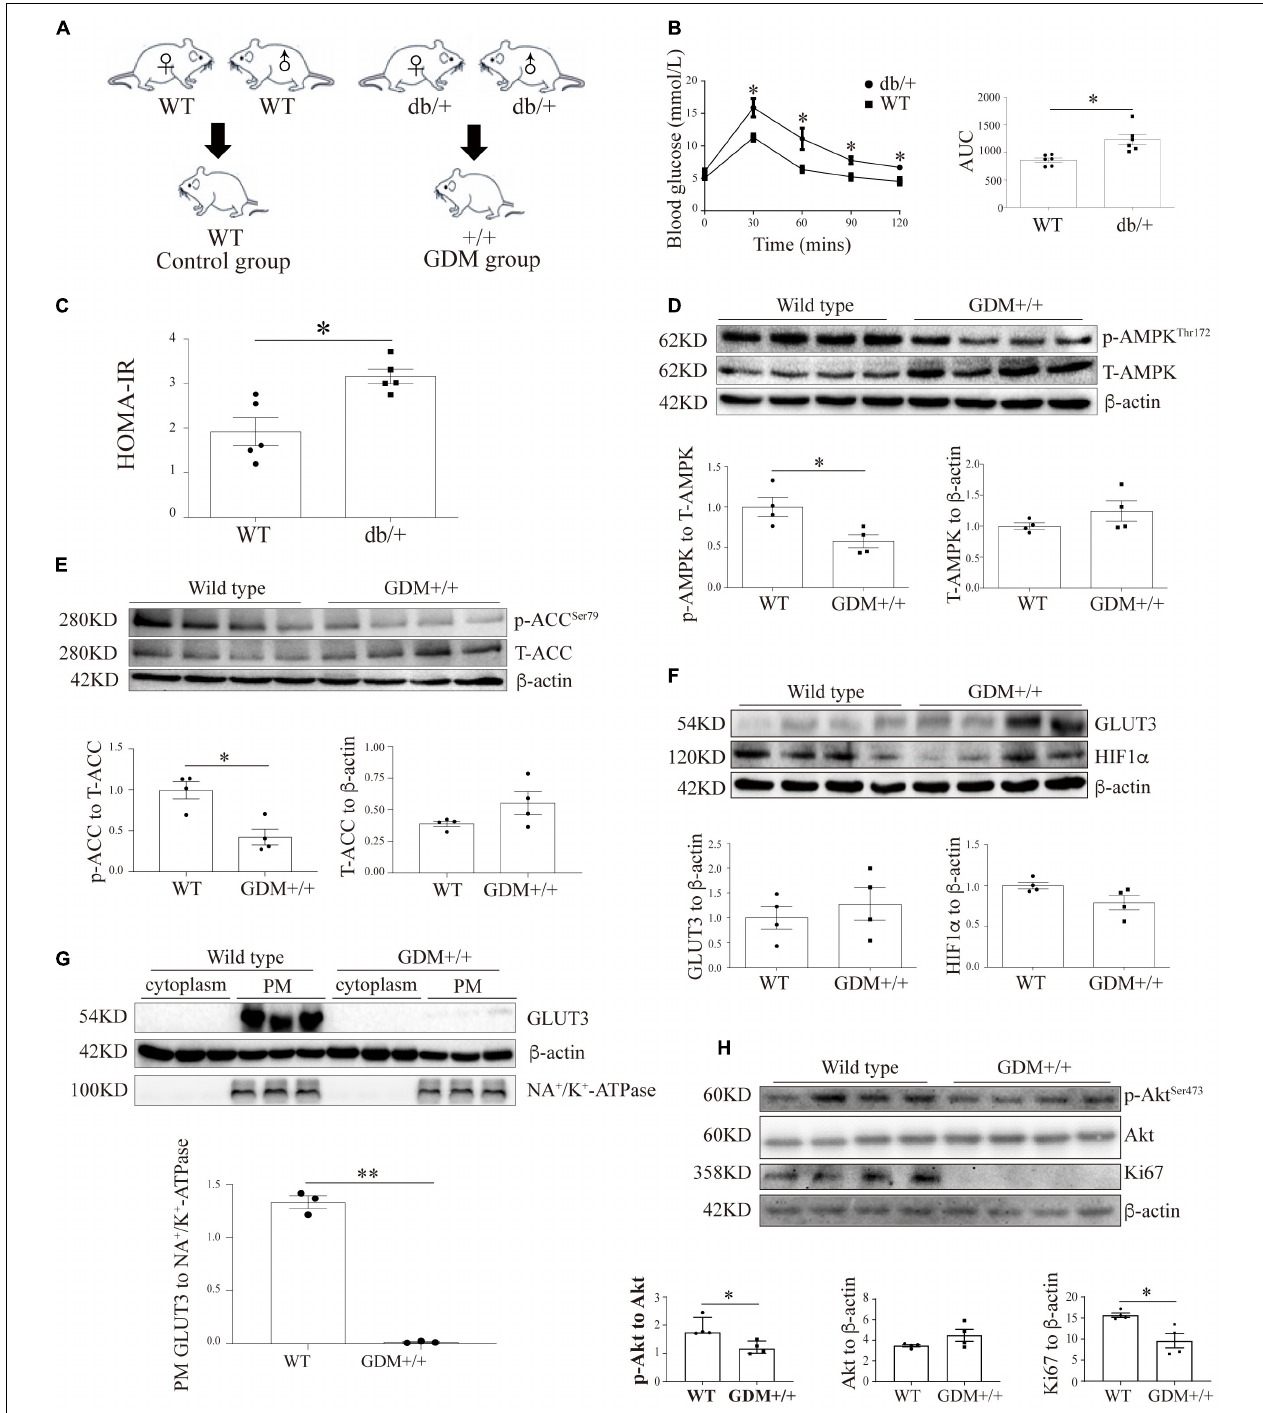
FIGURE 5 | The genetic GDM mouse model is associated with compromised AMPK signaling and altered GLUT3 membrane localization in placental tissue. (A) Animal mating plan and study groups. (B) OGTT and AUC values ( n = 6). (C) HOMA-IR scores ( n = 5). (D) Placental p-AMPK and AMPK levels in the GDM + / + and WT groups ( n = 7 from 4 dams). (E) Placental p-ACC and ACC levels in the GDM + / + and WT groups ( n = 7 from 4 dams). (F) GLUT3 and HIF-1 α protein expression in the GDM and WT placentas ( n = 7 from 3 dams). (G) PM-bound GLUT3 protein levels in GDM + / + and WT mouse placentas ( n = 7 from 3 dams). PM GLUT3 was normalized to NA + /K + -ATPase. (H) p-Akt, Akt and Ki67 protein levels in GDM + / + and WT mouse placentas ( n = 4). The data that are presented as the means ± SEMs are annotated in normal font, and Student’s t -test was used between two groups while ordinary ANOVA test was used among multiple groups. The data presented as the medians (IQRs) are shown in bold font, and Mann-Whitney test was used between two groups while Kruskal-Wallis test was used among multiple groups. ∗ p < 0.05 and ∗∗ p < 0.001.